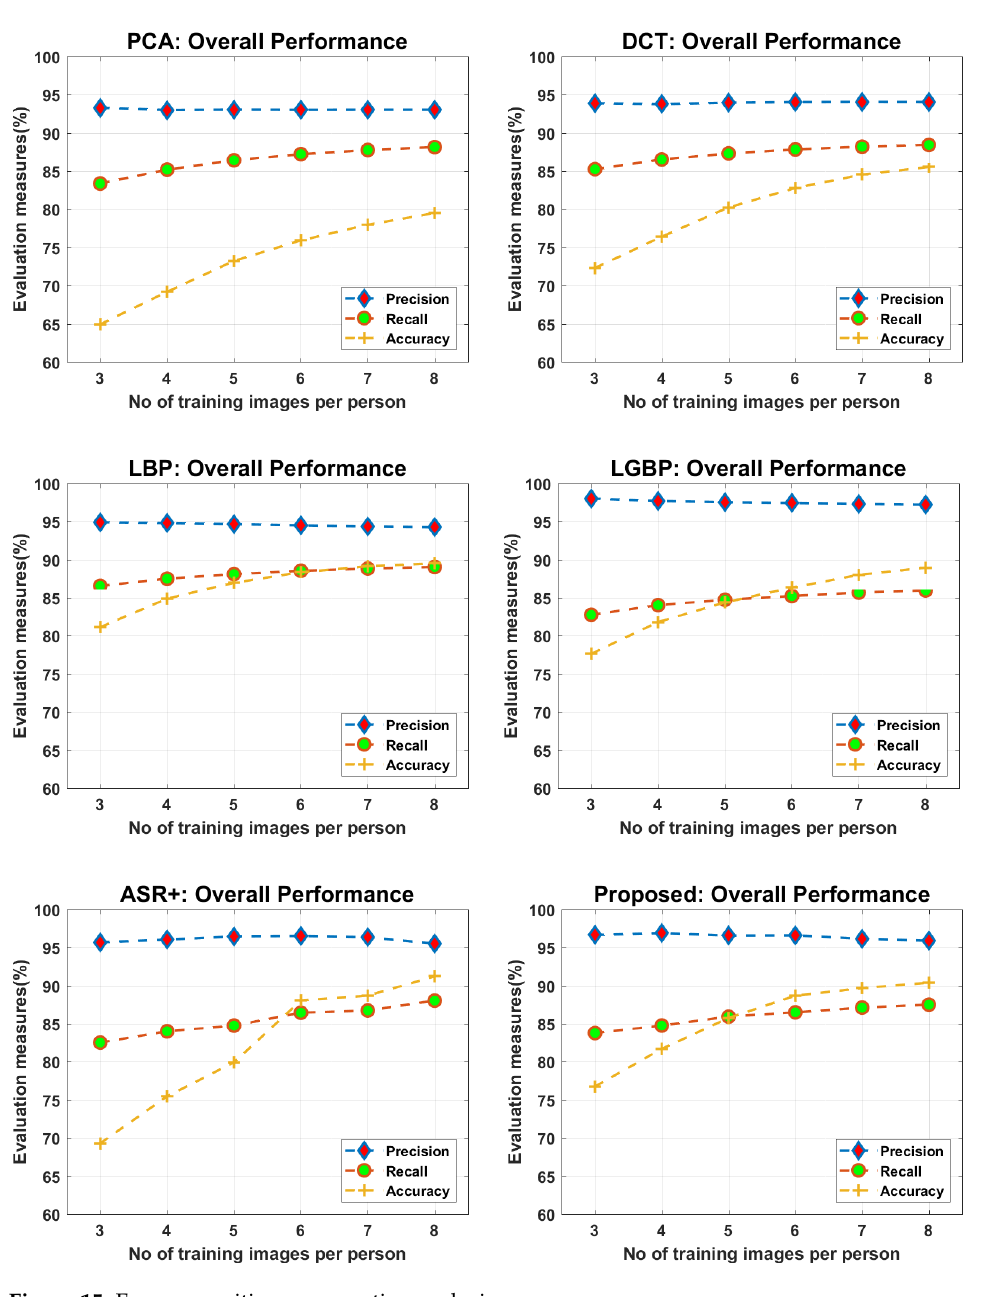
Figure 15. Face-recognition comparative